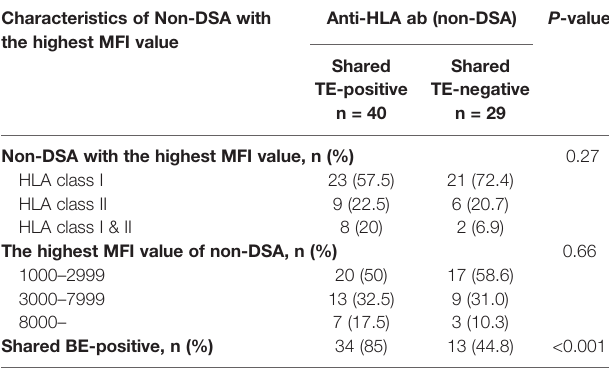
(HLAMatchmaker score), with a Spearman ’ s rho of 0.68 (p < 0.001; Figure 4A ). Conversely, the positive correlation between the